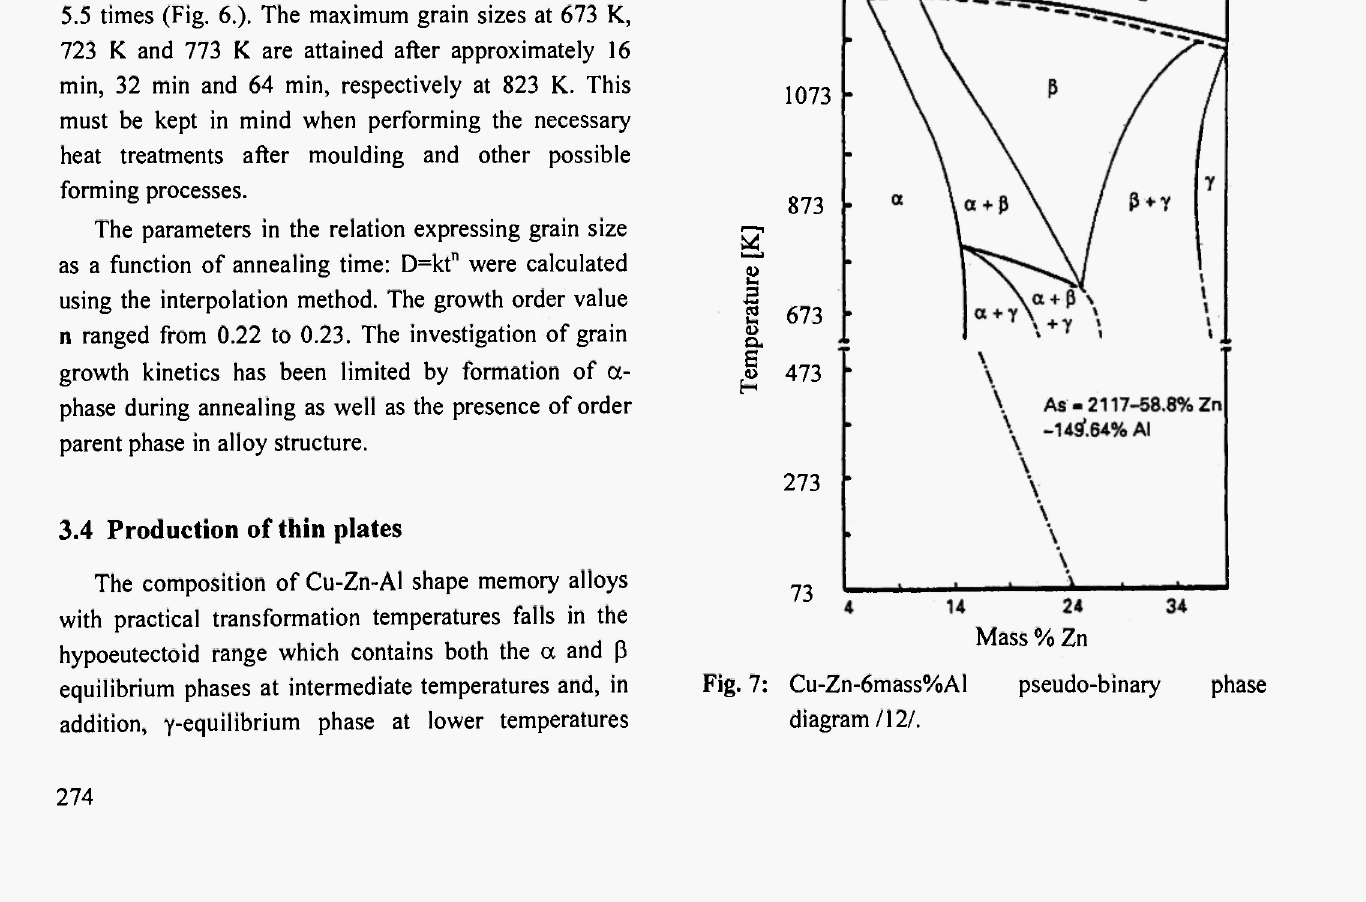
Fig. 6: The variation in grain area as function of annealing time at 823K.